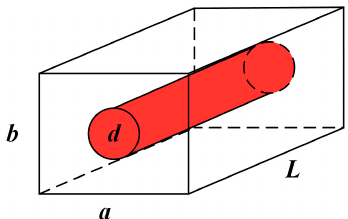
Figure 8. Parameters of square tube heat exchange area calculation.